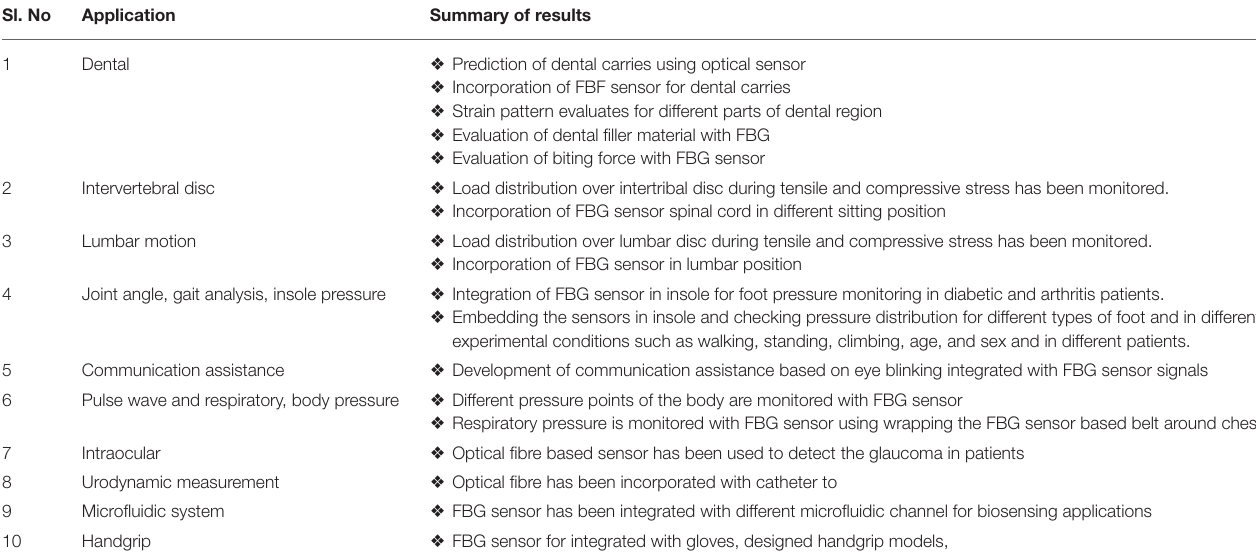
TABLE 3 | Summary of application. Sl. No